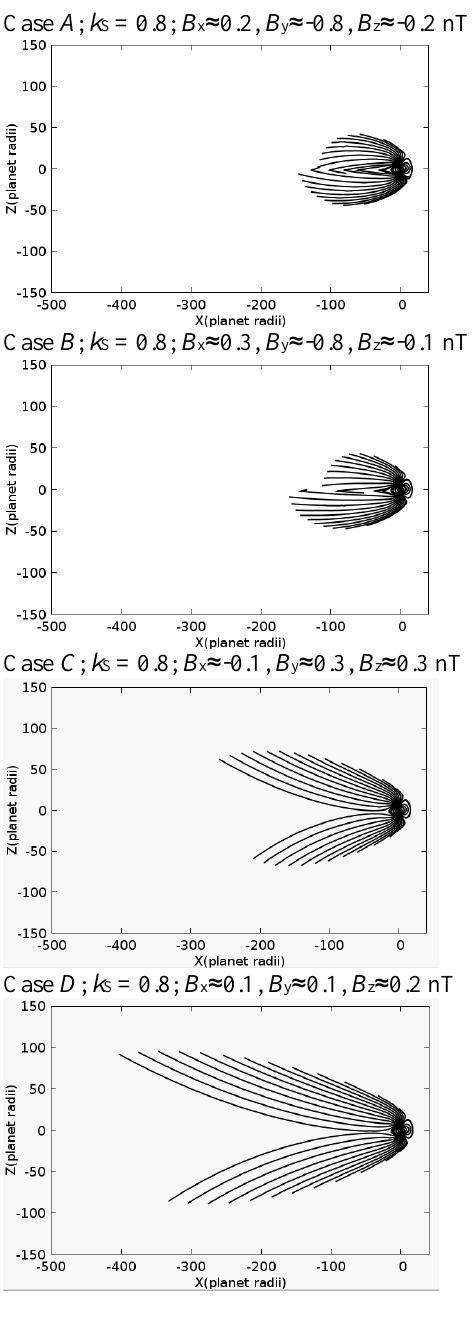
Fig. 4. Plots showing field lines emerging from Saturn’s ionosphere in the noon-midnight meridian for IMF vectors corresponding to HST images A, B, C, and D, as given at the top of each plot. In the left-hand plots k s =0.8, while on the right k s =0.2. Field lines on the nightside terminate where they intersect the